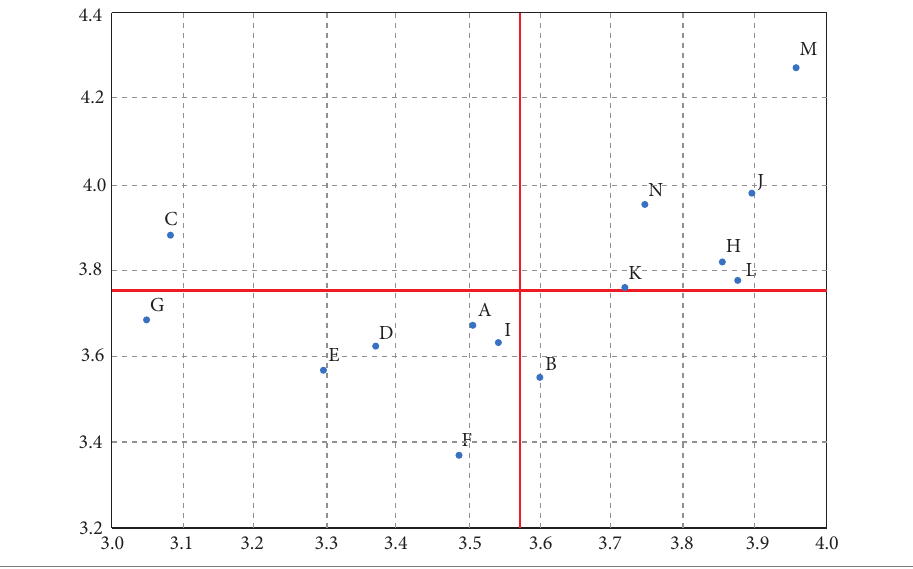
Fig. 7. The scatter diagram of parameters of relations of Polish enterprises with the subcontractor/main contractor